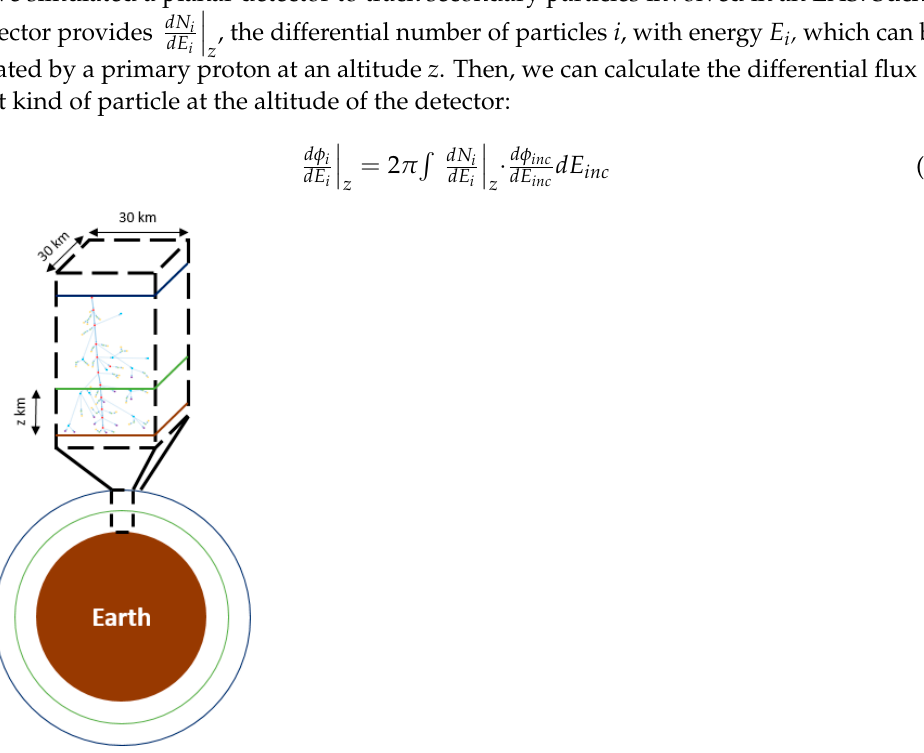
Figure 3. Schematic of the atmosphere and its projection in our Monte Carlo simulation.